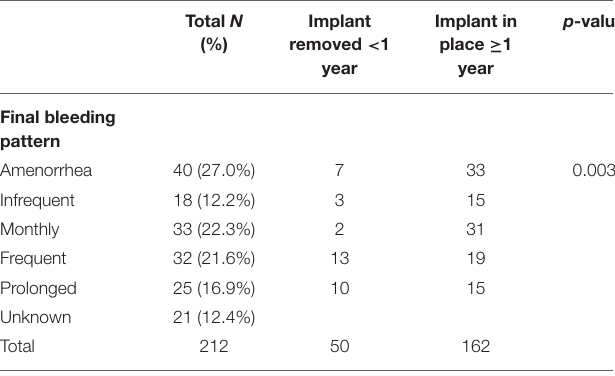
TABLE 4 | Bleeding patterns following implant